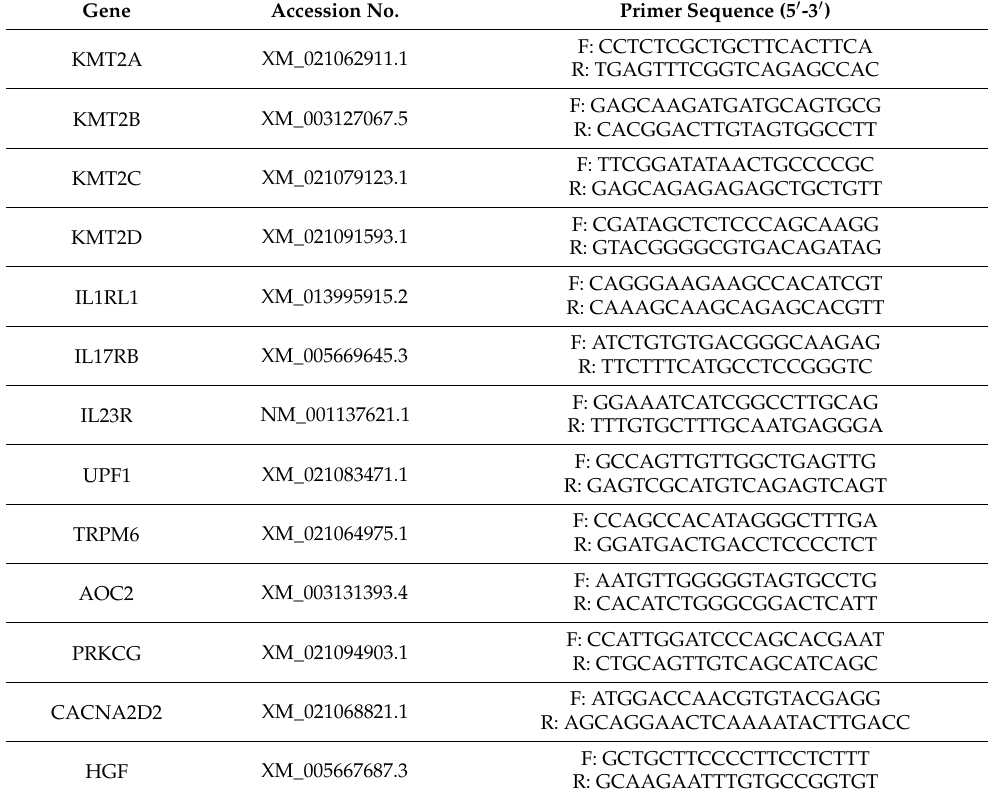
Table 1. Primers used for